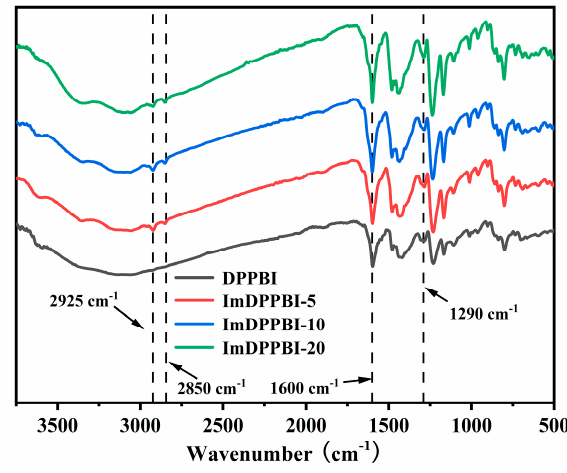
Figure 3. FT–IR spectra of the DPPBI and grafted ImDPPBI.